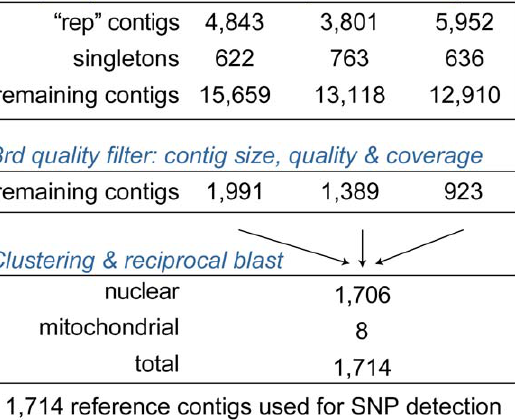
Figure 1. Summary of assembly, trimming and quality filtering of raw 454 sequence